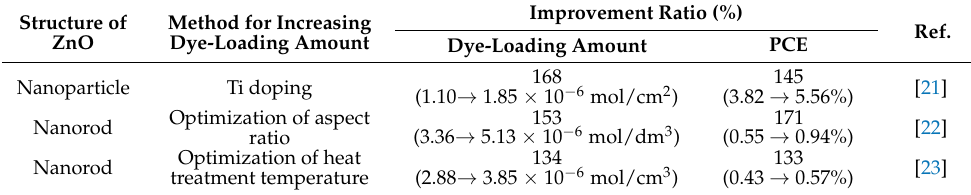
Table 1. Reported methods for improving dye-loading amount on the ZnO surface. Structure of